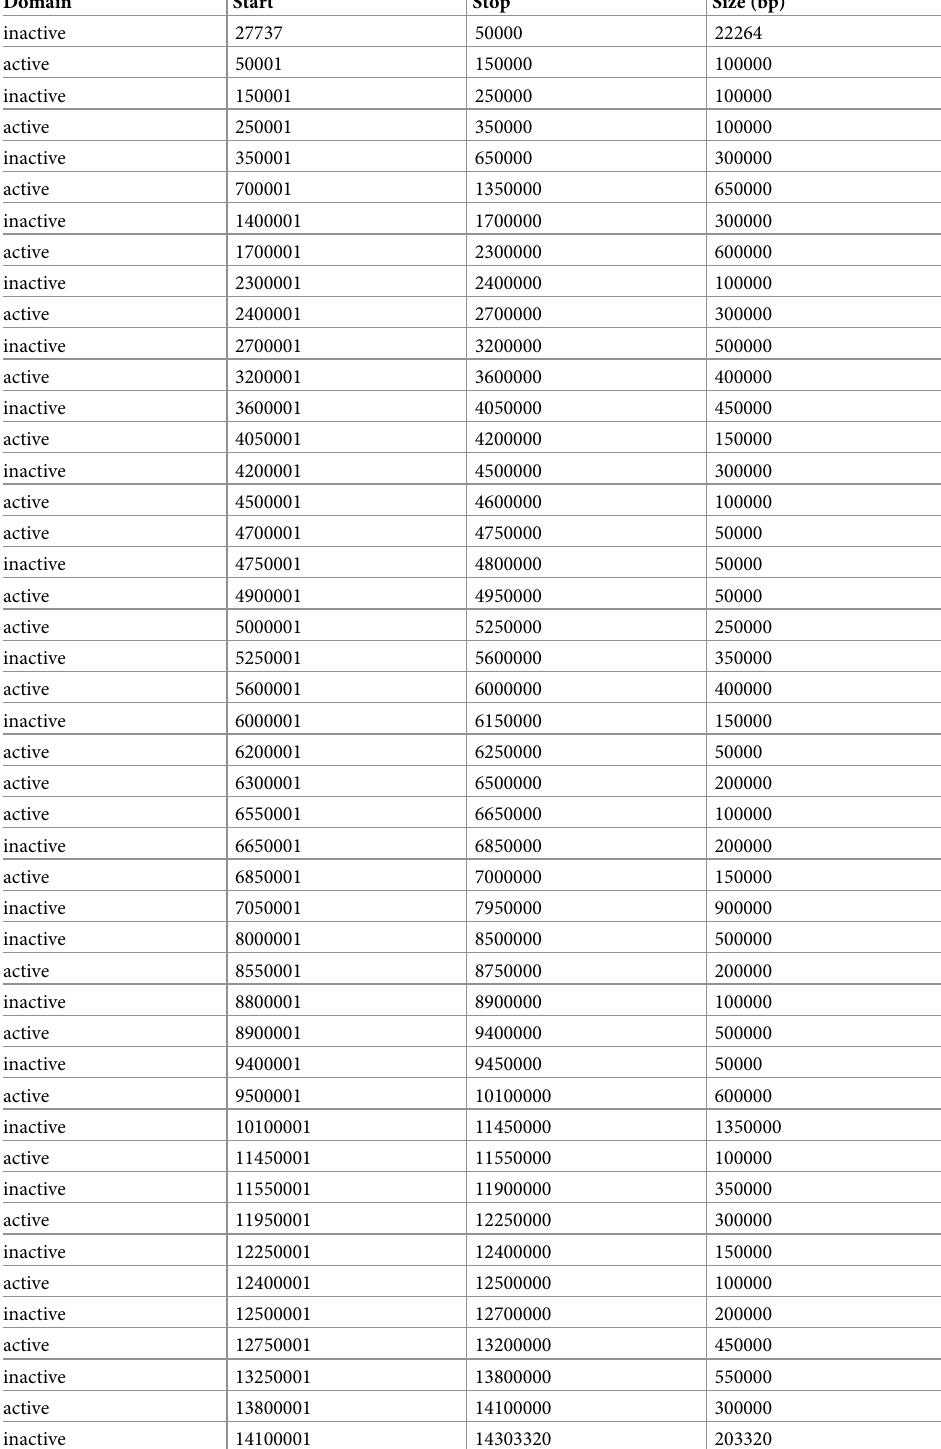
Table 5. Ch16 Active and inactive chromatin domains paint